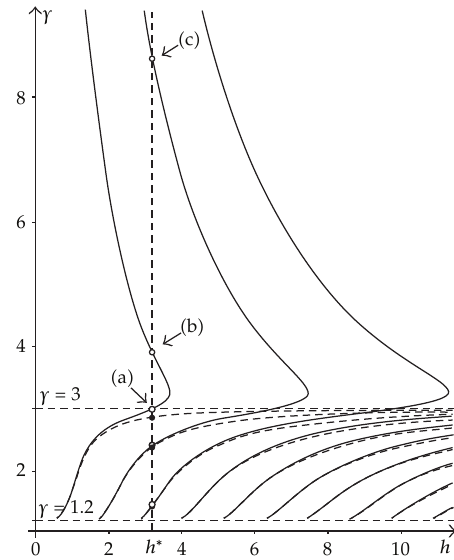
Figure 2: Plot of γ (cid:3) h (cid:4) . The first few dispersion curves are shown. Solid curves for the nonlinear case (cid:3) solutions of (cid:3) 7.14 (cid:4)(cid:4) ; dashed curves for the linear case (cid:3) solutions of (cid:3) 8.1 (cid:4)(cid:4) . The following parameters are used for both cases: ε 1 (cid:7) 1 . 44, ε 2 (cid:7) 9, ε 3 (cid:7) 1, and for the nonlinear case a (cid:7) 0 . 1, and E lines are described by formulas: h ∗ (cid:7) 3 . 206 (cid:3) thickness of the layer (cid:4) , γ (cid:7) 1 . 2 (cid:3) lower bound for γ (cid:4) , and γ (cid:7) 3 (cid:3) upper bound for γ in the case of linear medium in the layer (cid:4)